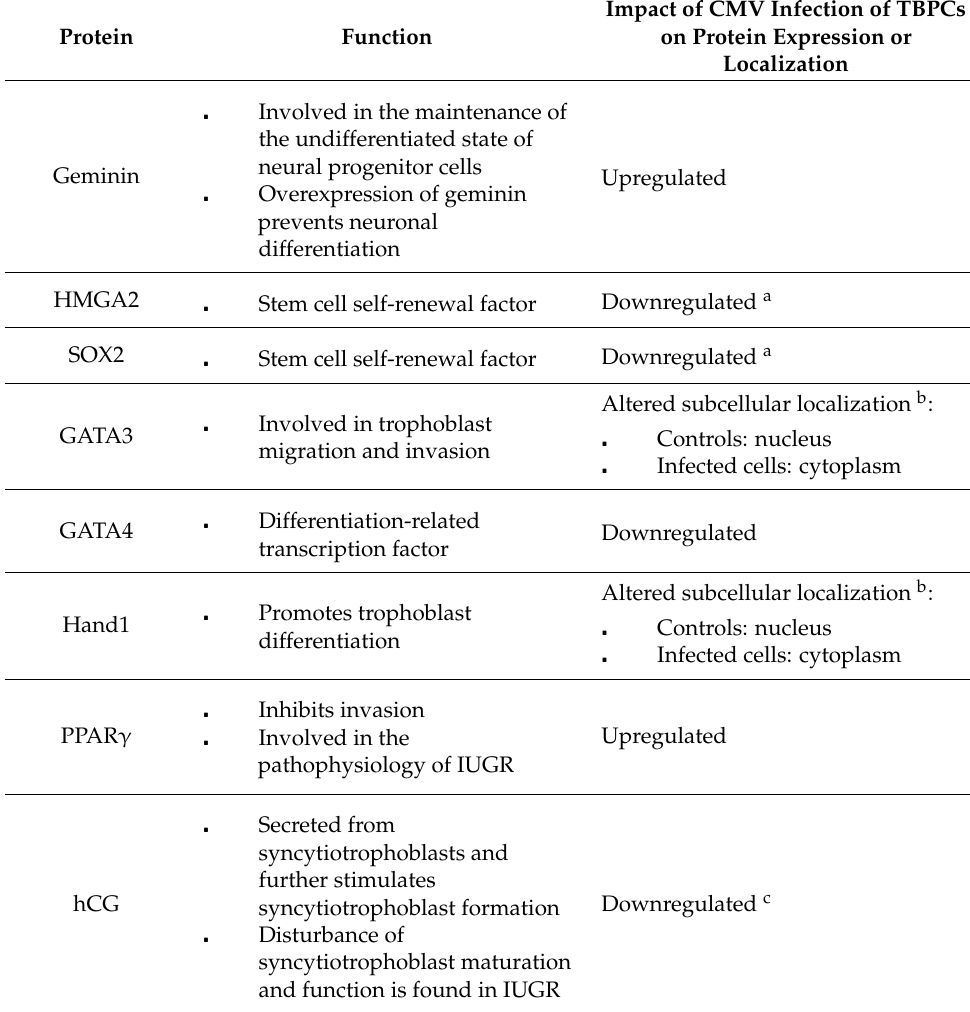
Table 3. Cytomegalovirus infection of TBPCs alters expression of key regulatory